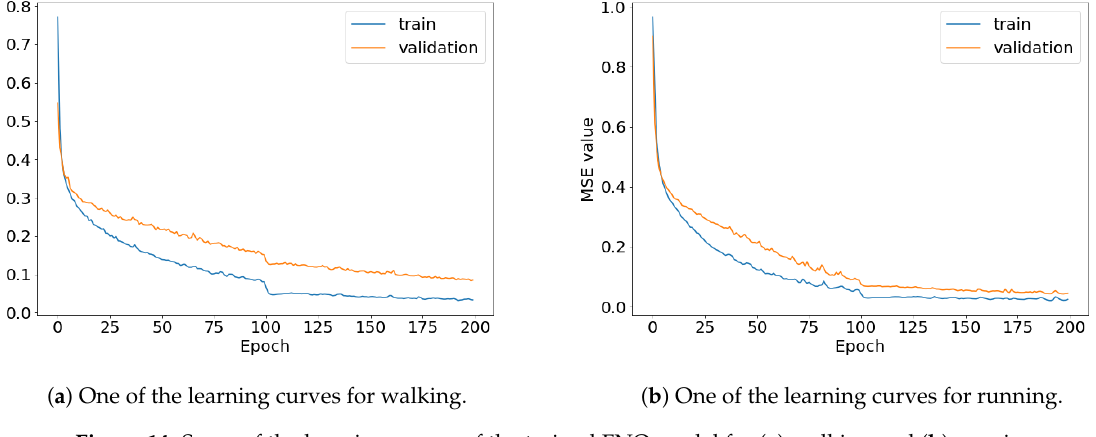
Figure 14. Some of the learning curves of the trained FNO model for ( a ) walking and ( b )